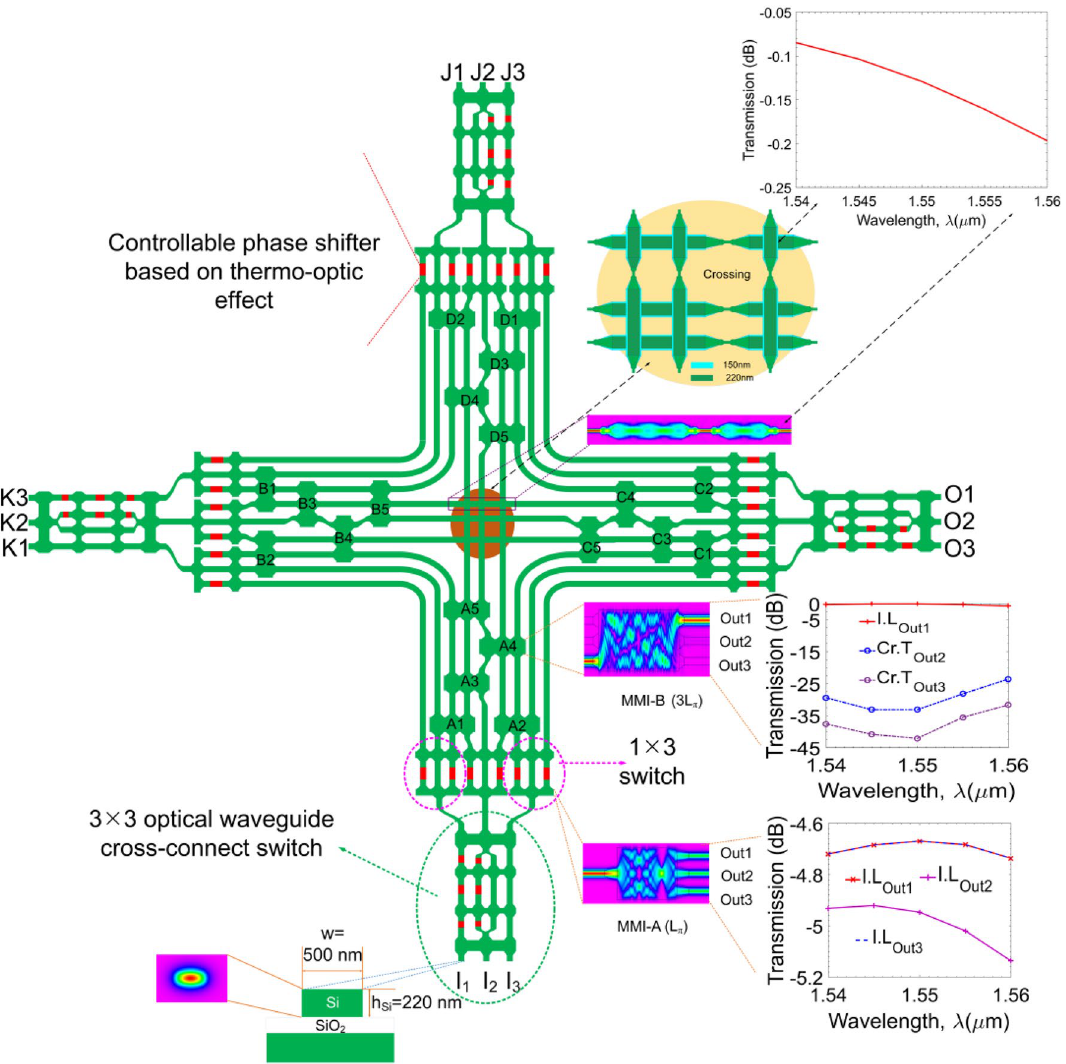
Figure 2. The architecture of our proposed four-degree 3 × 3 × 3 × 3 silicon photonic